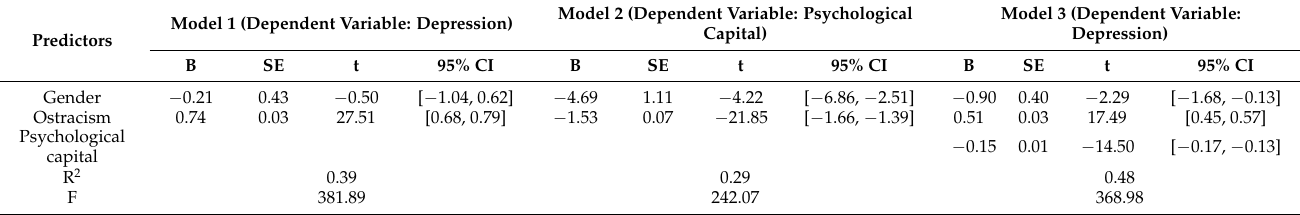
Table 2. Testing the mediation effect of psychological capital on depression. Model 1 (Dependent Variable: Depression) Model 2 (Dependent Variable: Psychological Predictors